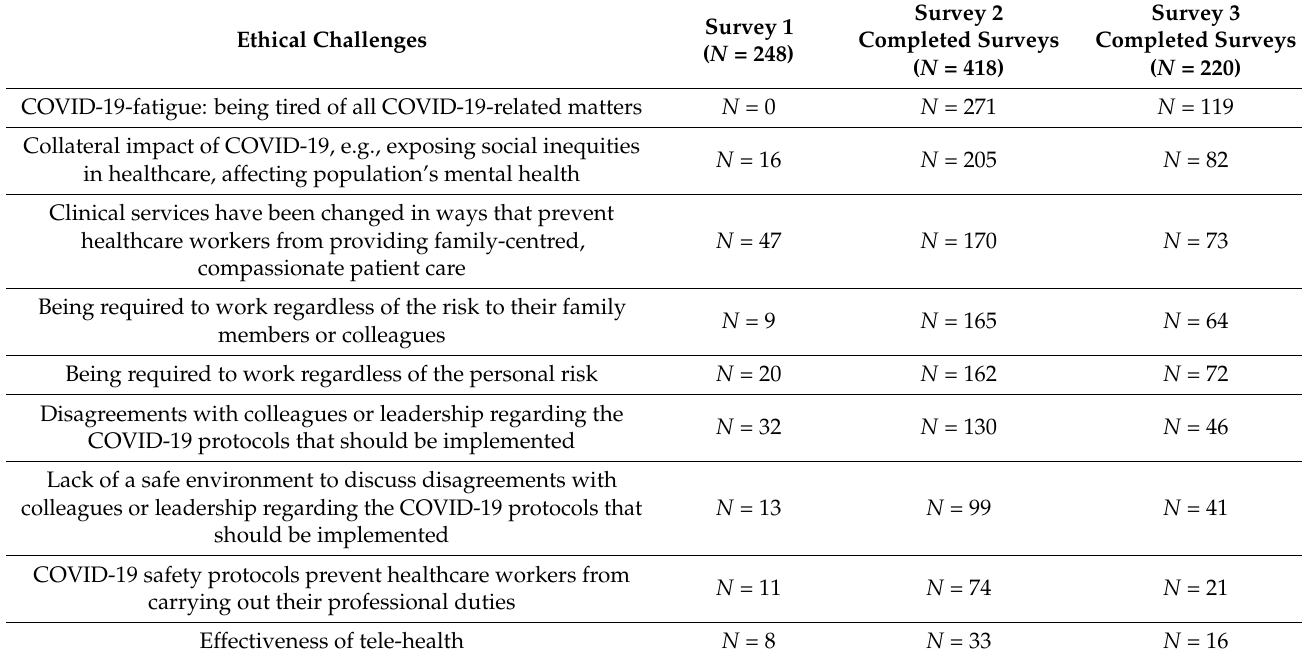
Table 2. Participants’ perspectives of the main ethical challenges faced, or to be faced, by HCW during the